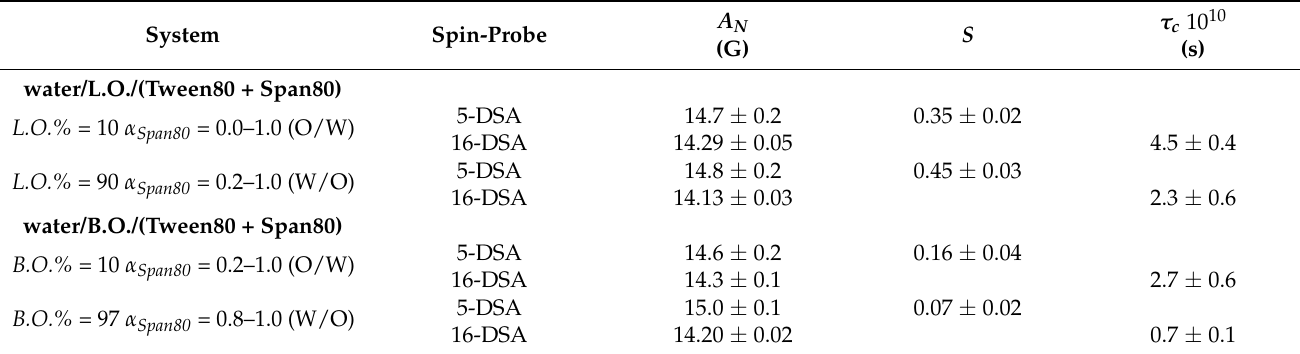
Table 1. EPR spectral parameters of 5-DSA and 16-DSA in water/L.O./(Tween80 + Span80) and water/B.O./(Tween80 + Span80) emulsions at 25 ◦